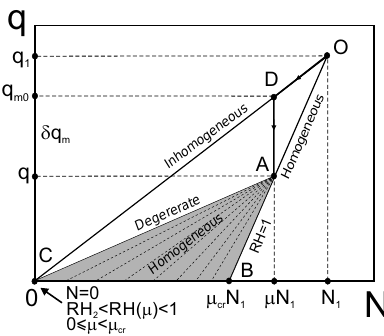
Figure 10. Conceptual diagram explaining breaking the functional relationships between the microphysical moment during progres- sive missing (see